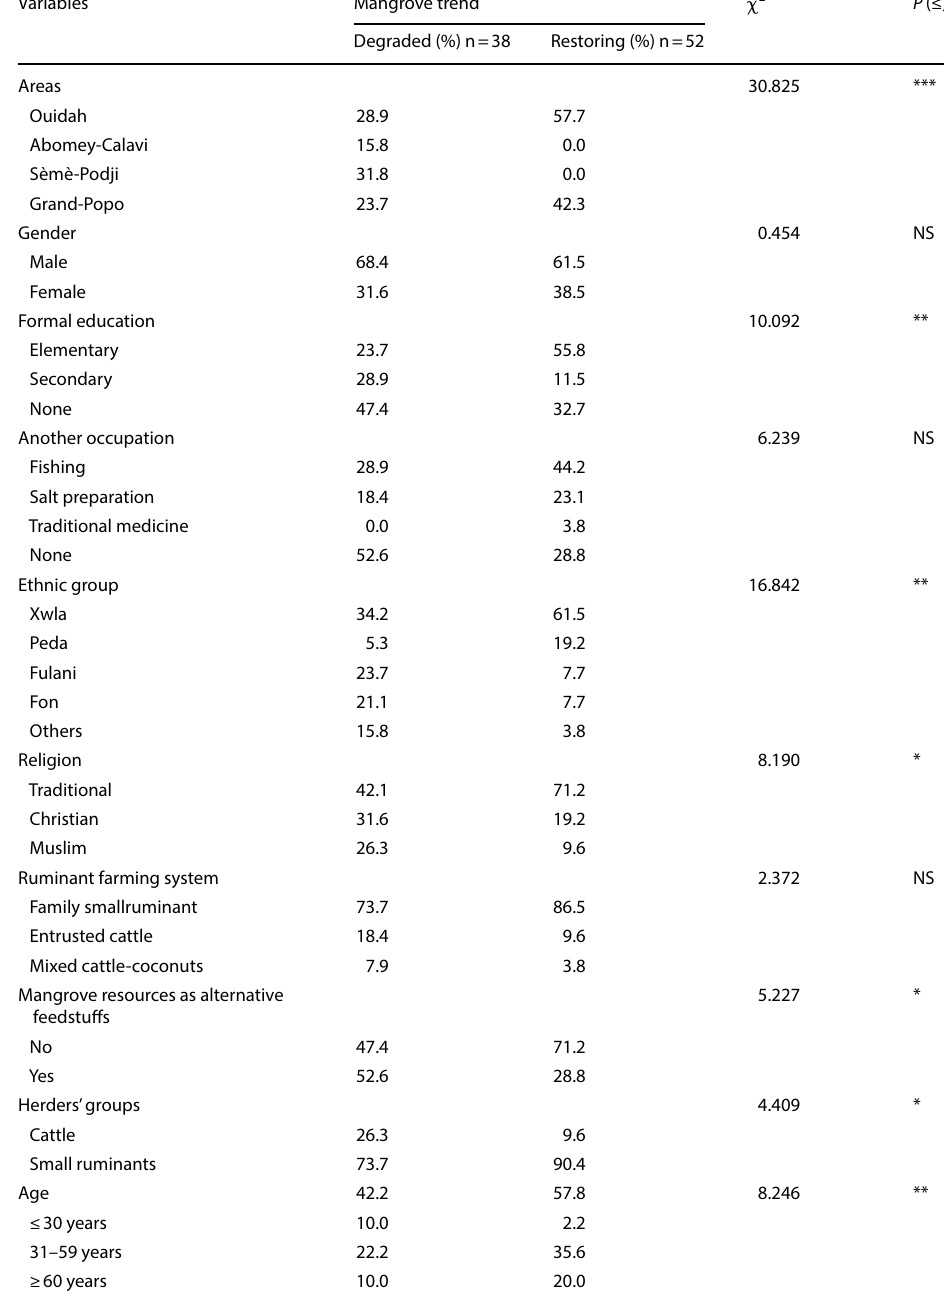
Table 3 Comparison of qualitative characteristics of farms around degraded and restoring mangroves